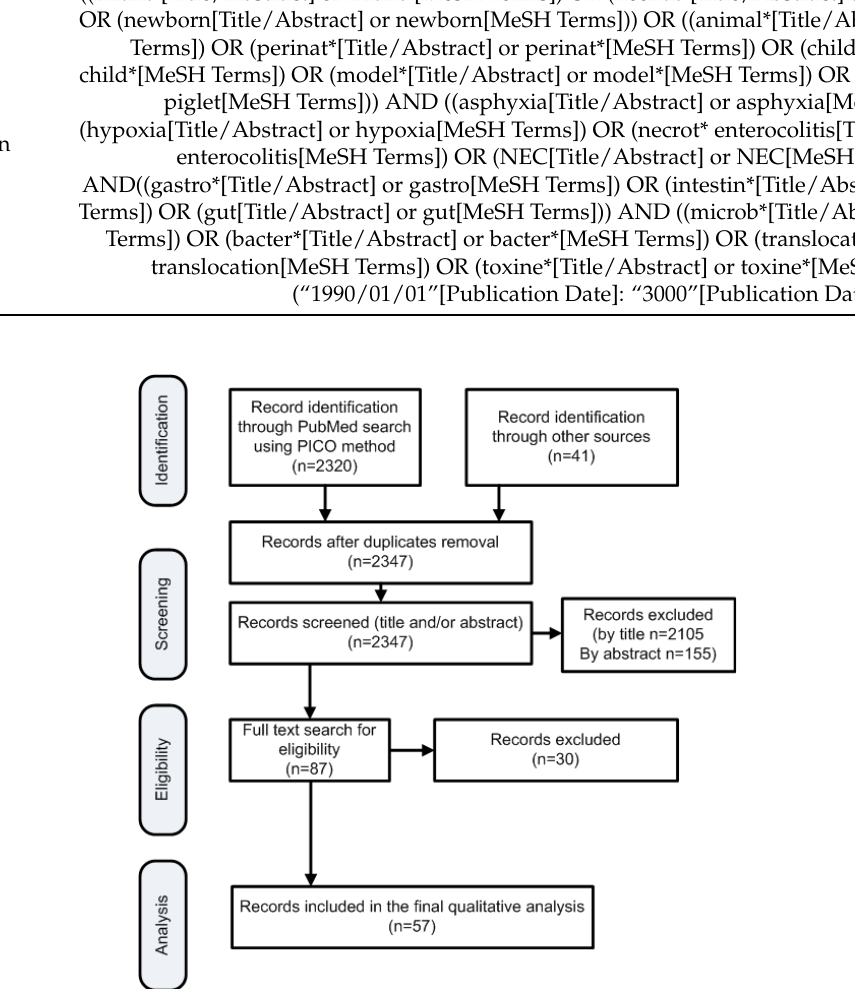
Figure 1. Flowchart of the search strategy according to the PRISMA framework.